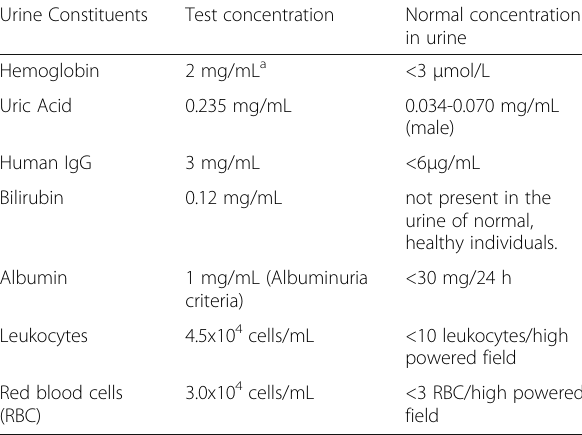
Table 2 Test concentrations versus normal concentration of endogenous substances in